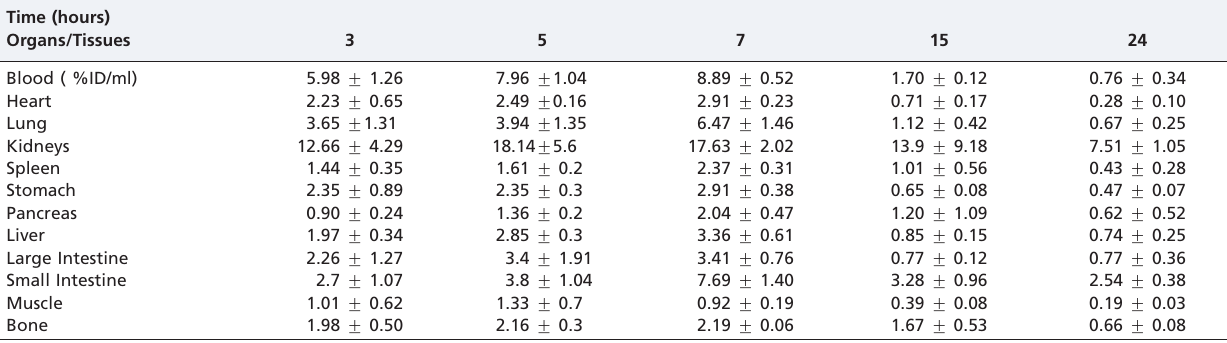
Table 2 - Biodistribution of (SA + B-MORF + B - b Ala -BBN) plus 99m Tc-MAG 3 -cMORF by pretargeting system in healthy animals.